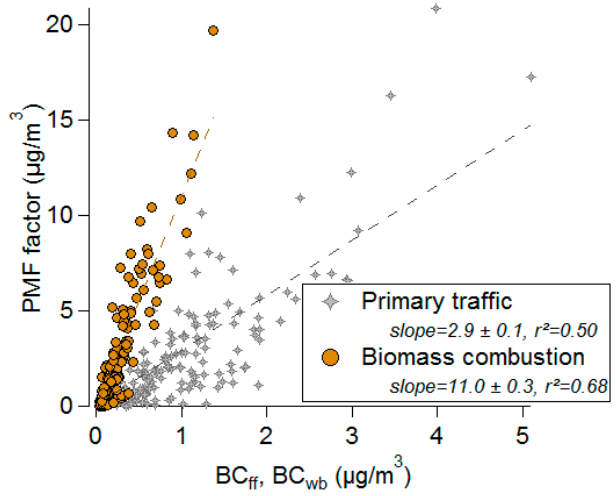
Figure 4. Scatter plot of the timeseries of primary traffic (grey) and wood burning (brown) factors versus the concentrations of BC ff and BC bb , respectively. Intercept for both fits was set to 0.